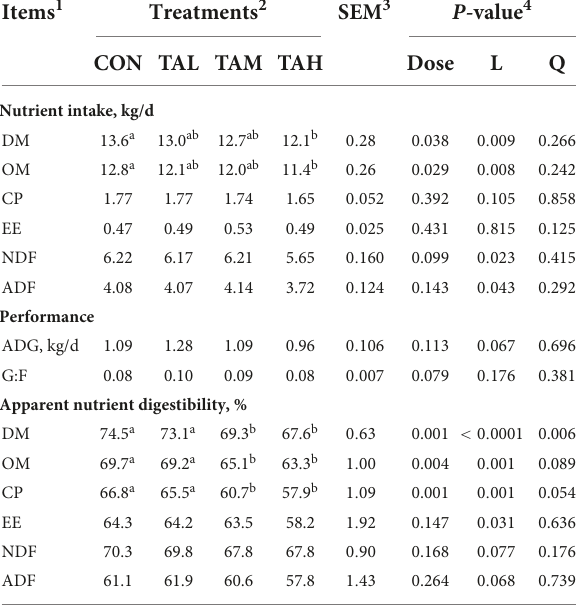
TABLE 2 Effects of tannic acid at different supplemental levels on nutrient intake, performance, and apparent nutrient digestibility of Holstein bulls.